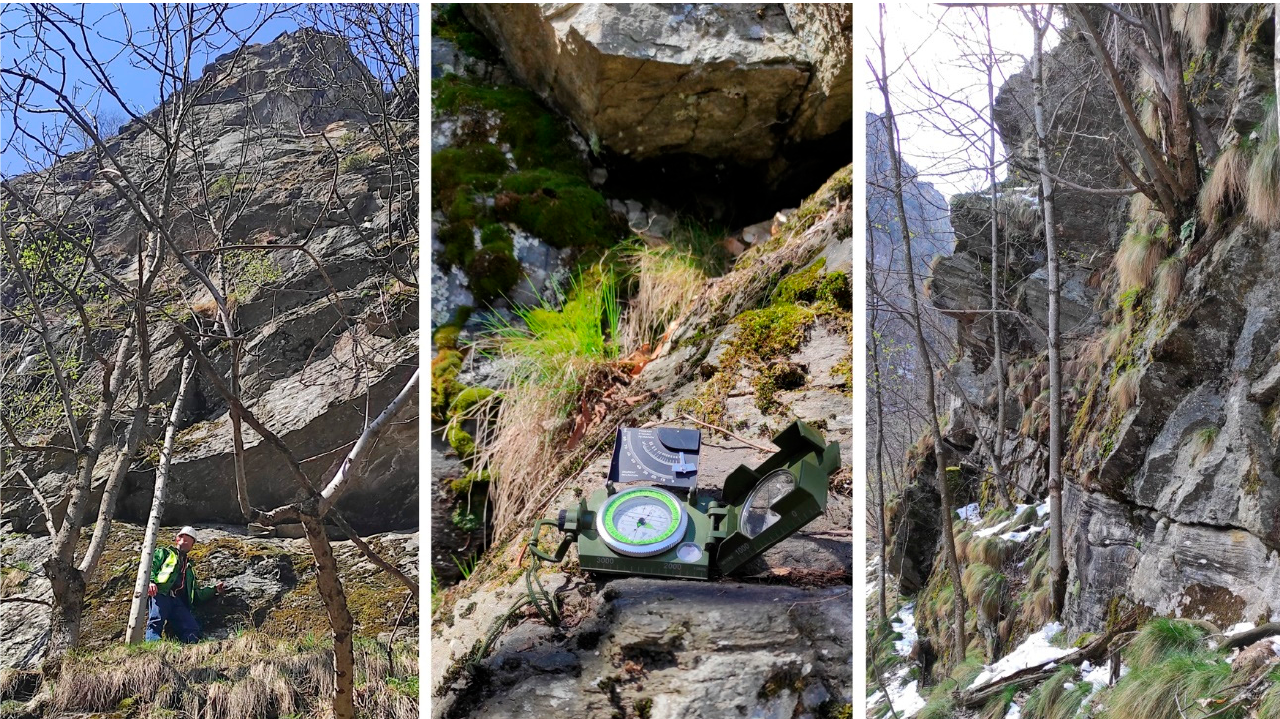
Figure 3. Some photos taken during the engineering–geological survey.